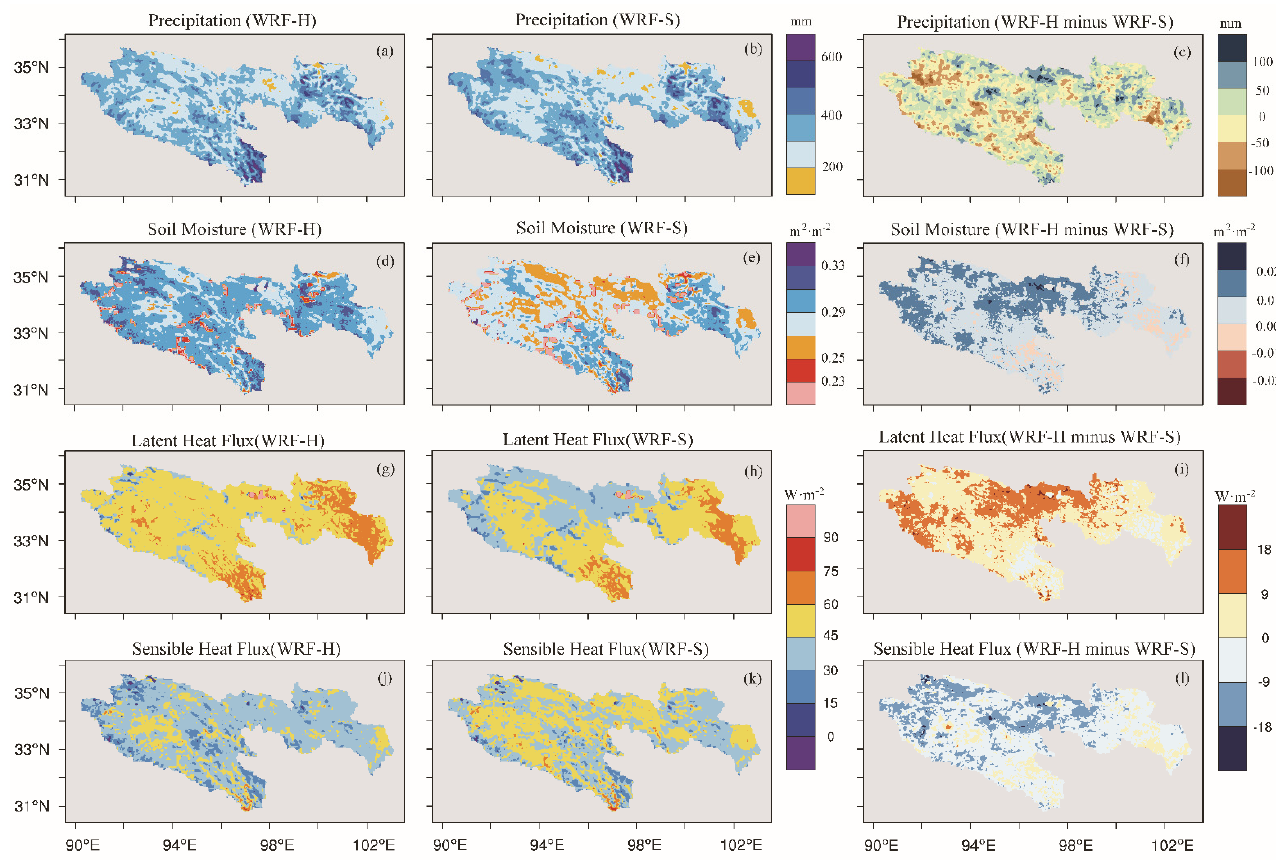
Figure 7. Spatial distribution of precipitation amounts from ( a ) WRF-H, ( b ) WRF-S, ( c ) WRF-h minus WRF-S over the study period. ( d–f ), ( g–i ) and ( j–l ) are the same as ( a–c ), but for averaged soil moisture (0~10 cm), averaged latent heat flux and sensible heat flux, respectively.